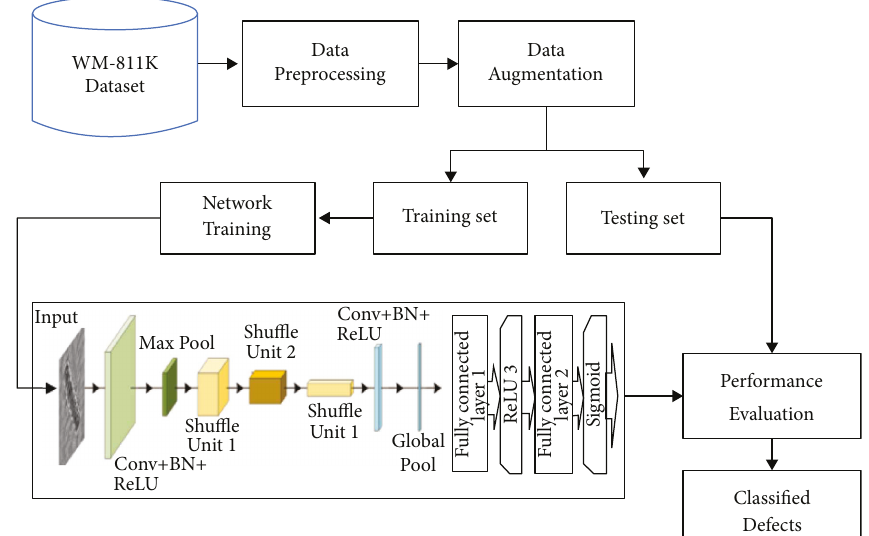
Figure 3: Workflow of proposed ShuffleNet-v2-CNN